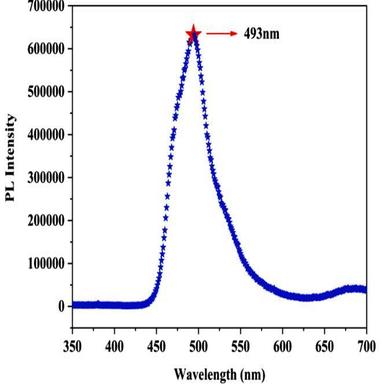
Emission spectrum of DADMQ.